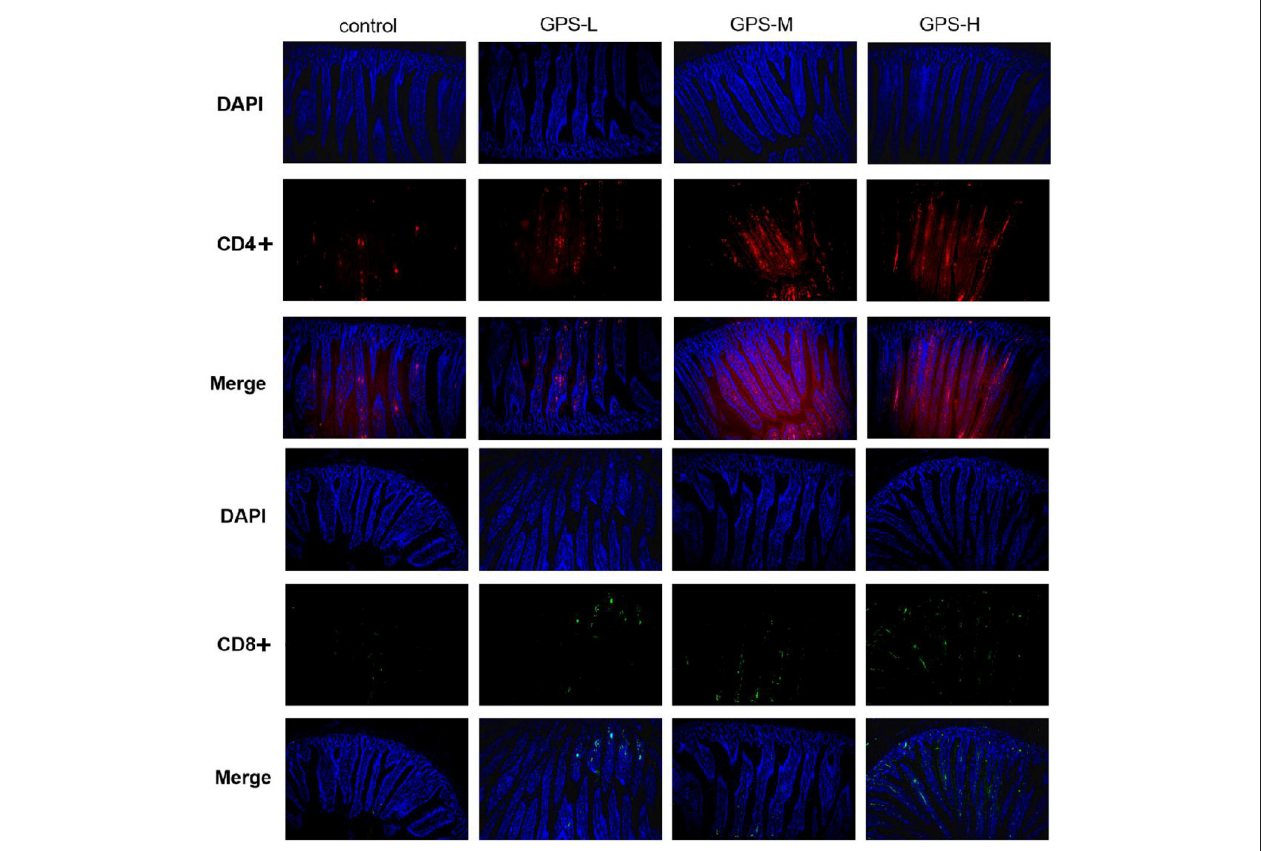
FIGURE 4 | The proportion of CD4 + and CD8 + T cells in the gut of laying hens after 14 days of oral GPS was analyzed using immunofluorescence. The nuclei were stained with DAPI (blue), the cell surface differentiation antigen CD4 + was stained with CY3 (red), and the cell surface differentiation antigen CD8 + was stained with FITC (green), which is convenient for visual inspection of the fluorescence